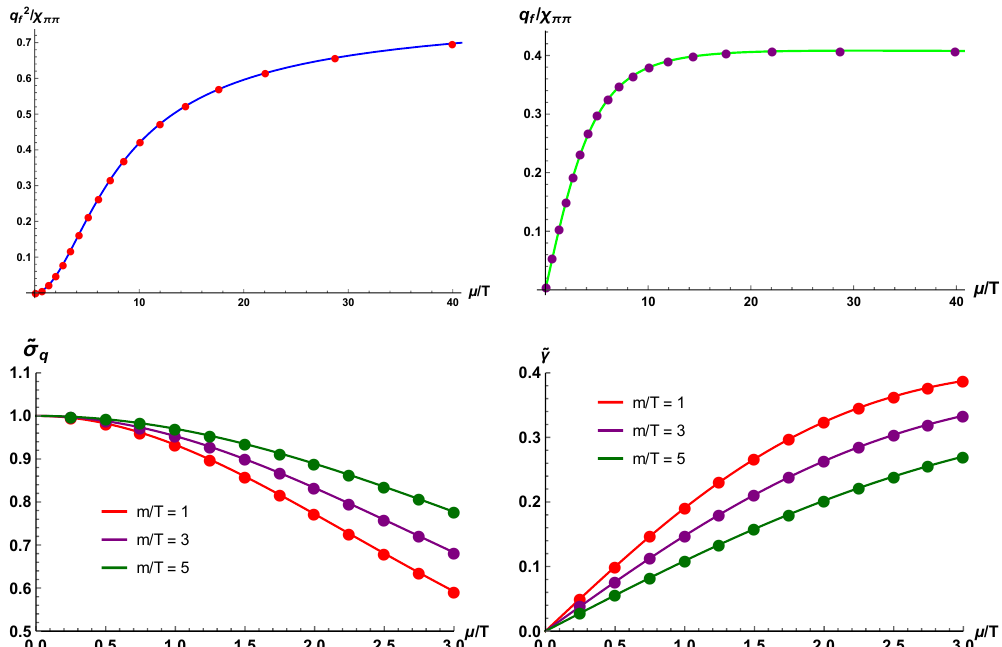
Figure 5 . Top Left: The real part of the JJ correlator (red dots) compared to the hydrodynamic formula for q 2 =(cid:31) (cid:25)(cid:25) (blue line). We (cid:12)xed m = u h = 1. Top Right: The imaginary part of the f mixed J (cid:8) correlator (purple dots) compared to the hydrodynamic formula for q f =(cid:31) (cid:25)(cid:25) (orange line). We (cid:12)xed m = u h = 1. Bottom Left: The parameter ~ (cid:27) q as a function of (cid:22)=T for several values of m=T . The lines are the analytic formula (4.20), while the dots are the numerical values extracted from the JJ correlator. Bottom Right: The parameter ~ (cid:13) as a function of (cid:22)=T for several values of m=T . The lines are the analytic formula (4.20) and the dots the numerical values extracted from the J (cid:8)